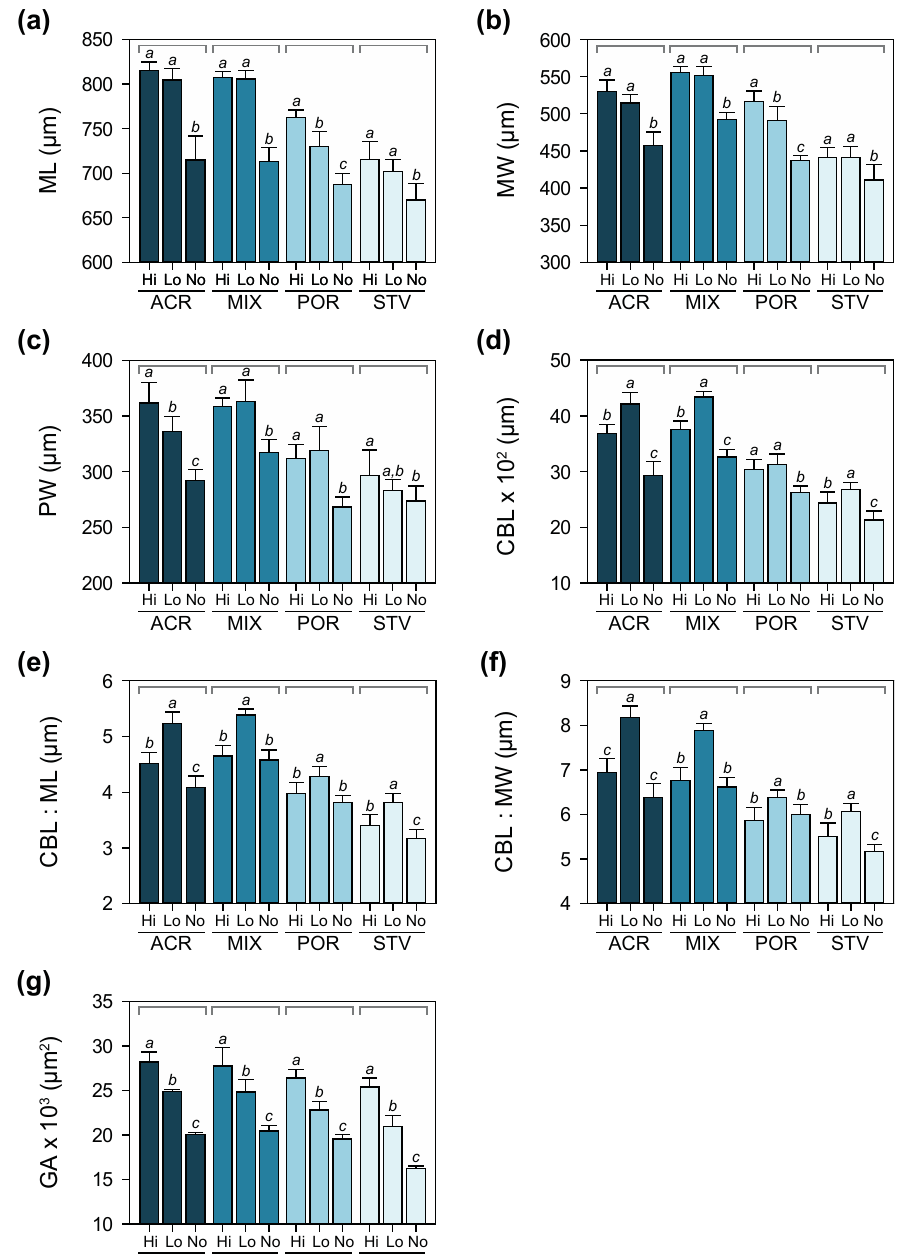
Figure 6. Morphometric measurements of larvae (± SD) at Day 10: ( a ) maximum length ( ML ), ( b ) maximum width ( MW ), ( c ) posterior width ( PW ), ( d ) ciliated band length ( CBL ), ( e ) ratio of CBL to ML, ( f ) ratio of CBL to MW , and ( g ) gut area ( GA ). Different letters above bars indicate significant differences based on Tukey’s post hoc tests following two-way ANOVA.